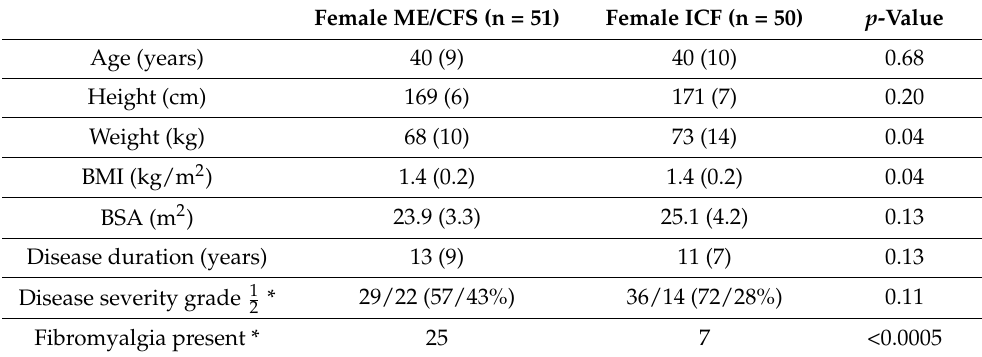
Table 1. Baseline characteristics.